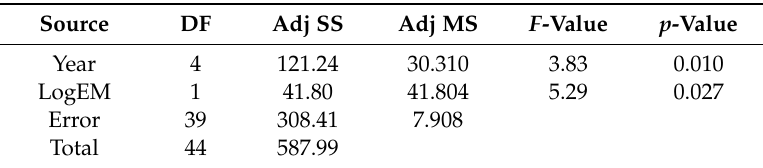
Table 6. Analysis of Variance table for log odds of survival in the field against log odds of combined survival in rearing, year, and insecticide treatment (Equation (8)). R 2 = 0.47.